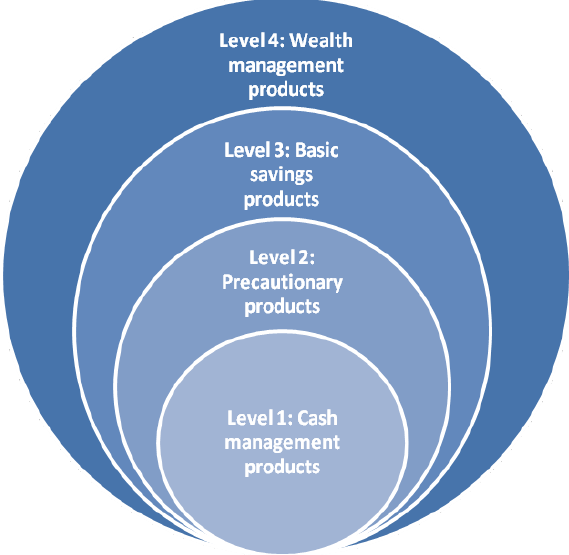
FIGURE 1: South African financial product usage hierarchy Source: Venter & Stedall,